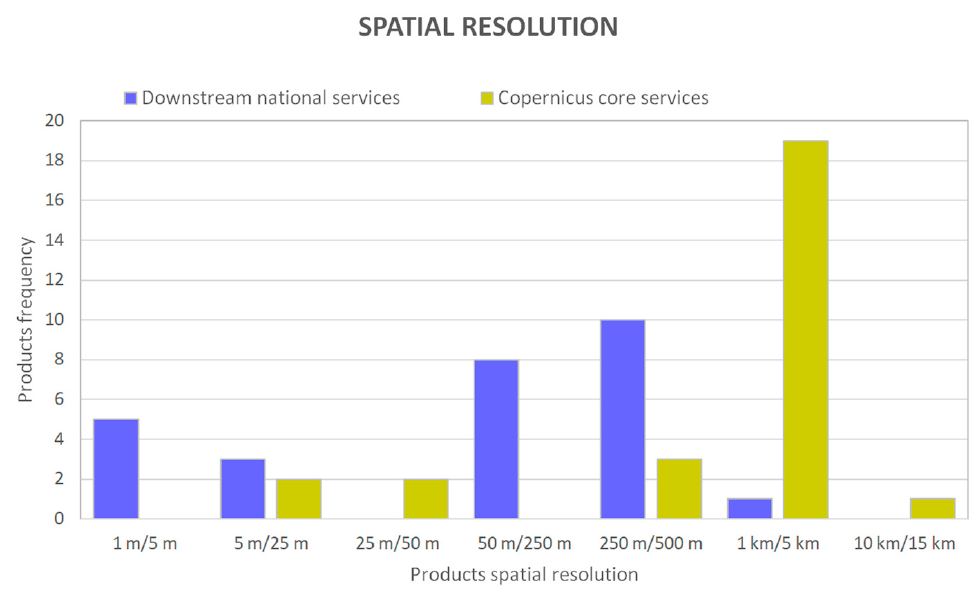
Figure 8. Spatial resolution gap between downstream national services (blue), Copernicus Core services (green).